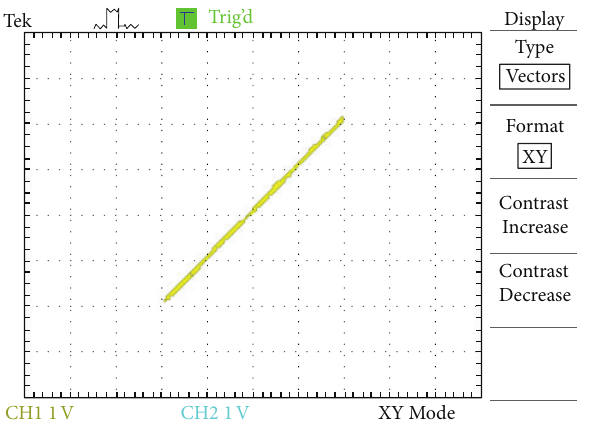
Figure 9: Synchronization phase diagram of the signals 𝑧 𝑡 (𝑡) - versus- 𝑧 𝑟 (𝑡)